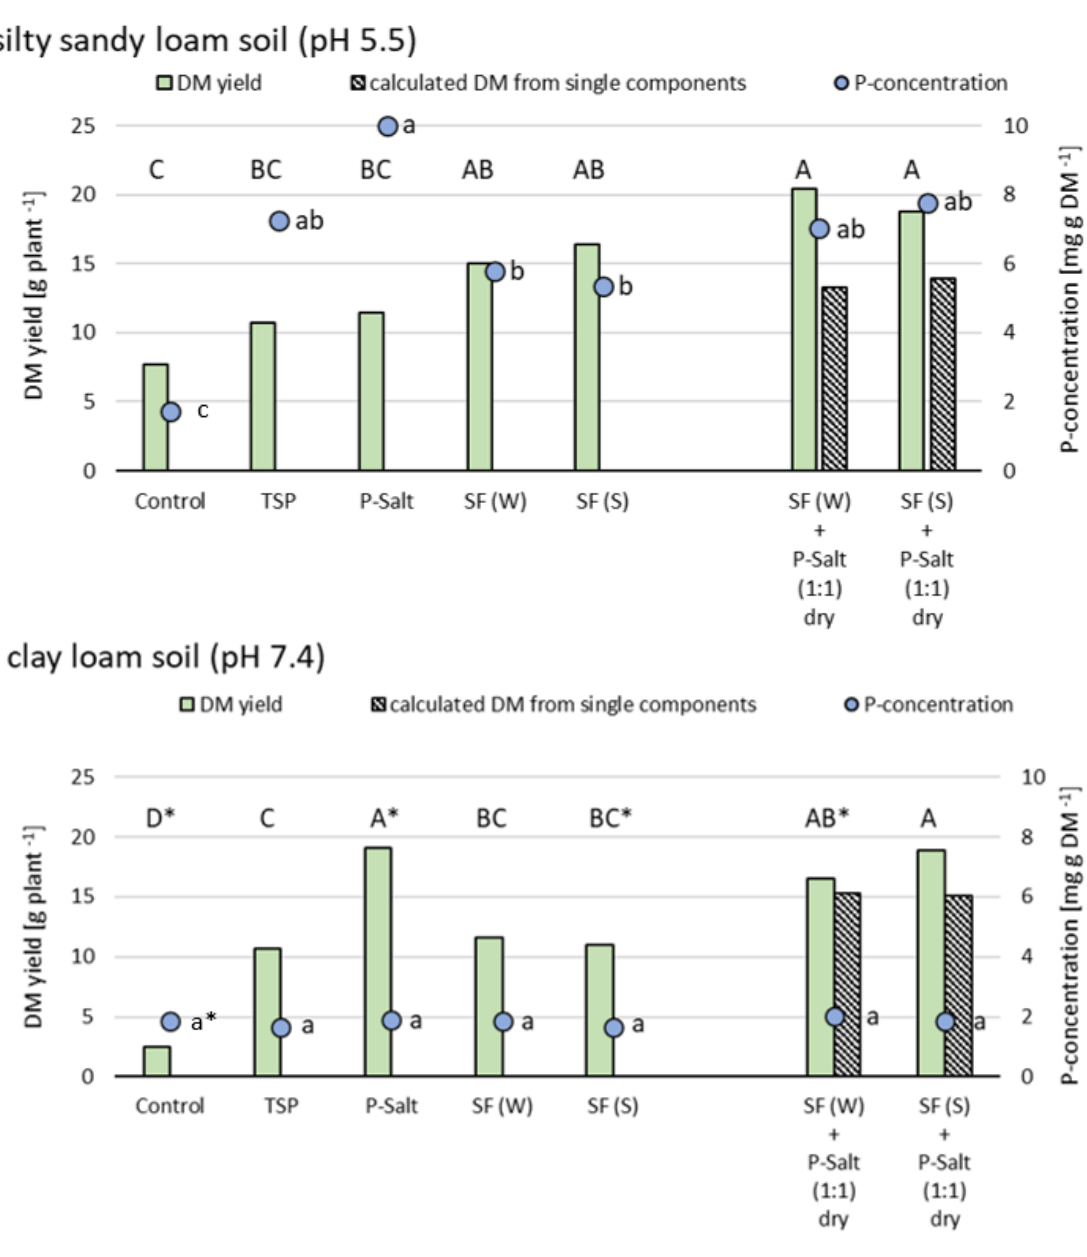
Figure 2. Mean shoot dry matter yield (DM yield) after 50 days in g plant − 1 and mean shoot P concentration of maize in mg DM plant − 1 after soil treatment with different recycled fertilizers in a total dose equivalent to 150 mg P (kg soil) − 1 ; fractions tested: P-enriched precipitate from the liquid fraction (P-Salt), air-dried solid fraction (SF(W)), steam-dried solid fraction (SF(S)), and two different combinations of them, compared to unfertilized control and triple superphosphate (TSP). Based on the total fertilizer dose corresponding to 150 mg P (kg soil) − 1 , designation (1:1) means that fertilizers were applied with a mass portion of SF (W or S) containing 75 mg P (kg soil) − 1 + a mass portion of P-Salt containing 75 mg P (kg soil) − 1 . “Calculated DM yields from single components” represent a mathematical calculation of the combinations based on the results of the real DM yield of the single components (P-Salt, SF(W), SF(S)) to indicate possible additive or synergistic effects (see Materials and Methods: Evaluation of Synergistic Effects, Equation (1)). Data are means of four replicates each. Different letters denote significant differences (two factorial Tukey test with p ≤ 0.05), and significant differences between the soils are indicated by an asterisk (*).